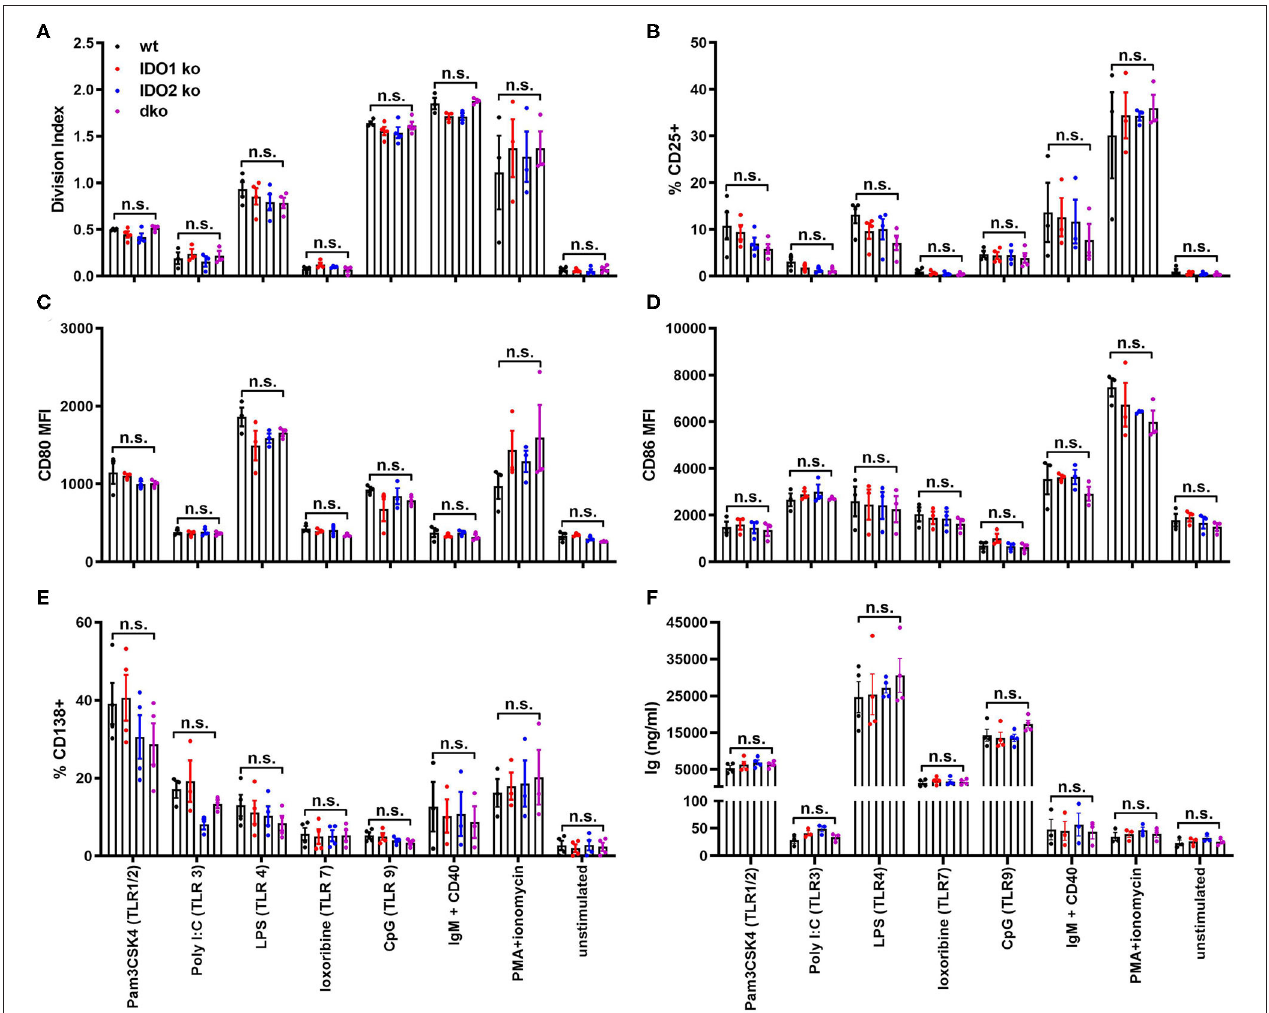
FIGURE 6 | IDO2 ko B cells respond normally to stimulation with TLR ligands in vitro . Purified IDO1 ko, IDO2 ko, dko, or wt B cells were labeled with CFSE and stimulated in vitro with Pam3CSK4 (TLR1/2), Poly I:C (TLR3), LPS (TLR4), loxoribine (TLR7), CpG (TLR9), anti-IgM + anti-CD40, PMA + ionomycin, or media alone for 48h. The cultured cells were then analyzed for (A) proliferation and the upregulation of activation markers (B) CD25, (C) CD80, (D) CD86, and (E) differentiation marker CD138 by flow cytometry. (F) The amount of Ig secreted into the supernatant was measured by ELISA. Symbols represent individual mice and histograms show mean ± SEM, pooled from a minimum of 3 independent experiments. P -values were calculated by one way-ANOVA followed by comparison of means with Tukey’s post-hoc multiple comparison correction. n.s., not